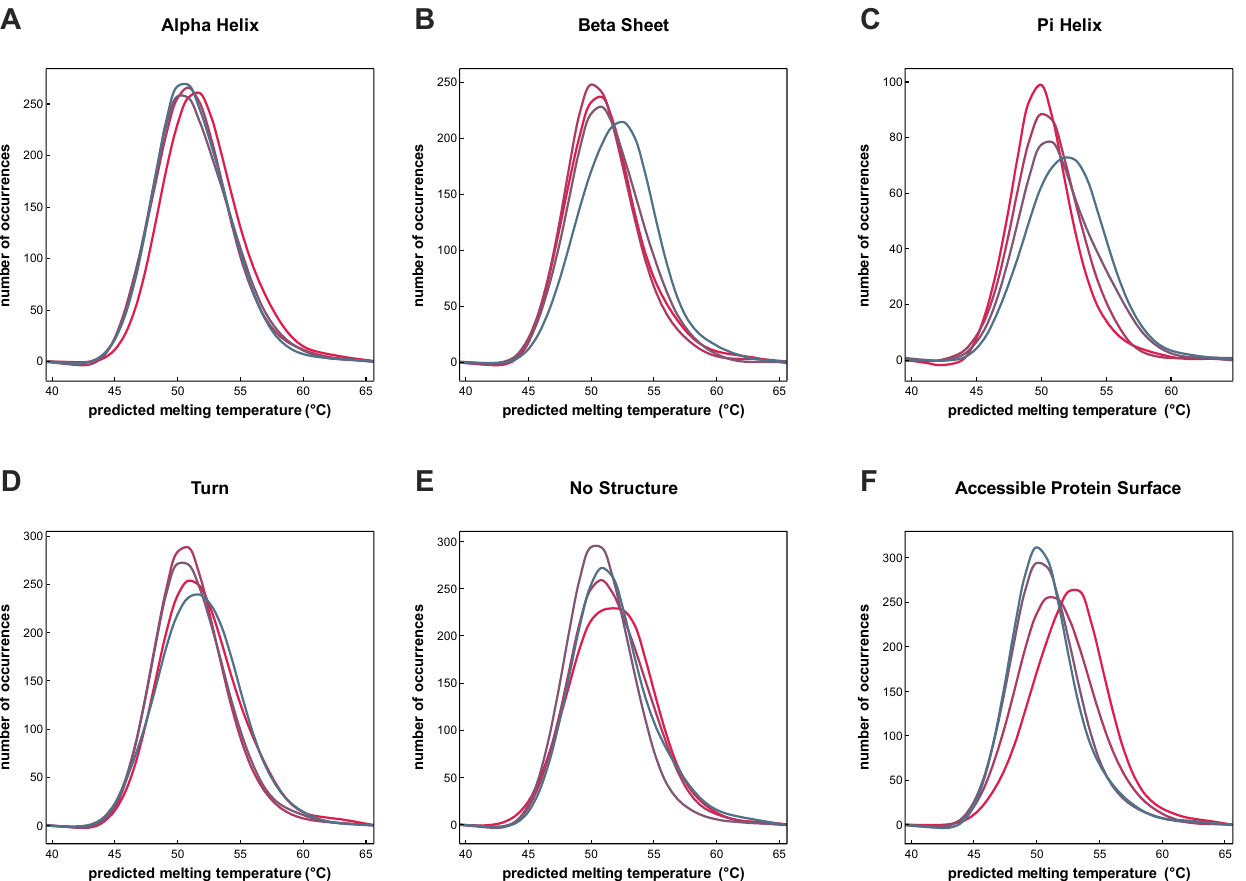
Figure 5. Analysis of dependencies between protein melting temperature and the secondary structure elements AlphaHelix ( A ), BetaSheet ( B ), PiHelix ( C ), Turn ( D ), NoStructure ( E ), and the Accessible Protein Surface ( F ). After binning each protein according to its T m , each protein was classified according to its value in the respective property into quartiles. Quartile one (grey), quartile two (purple), quartile three (dark pink), and quartile four (red). Observed distributions of protein-wise aggregates show distinct shapes with small (AlphaHelix) to large differences (e.g., Accessible Protein Surface) in the quartile-wise distributions.